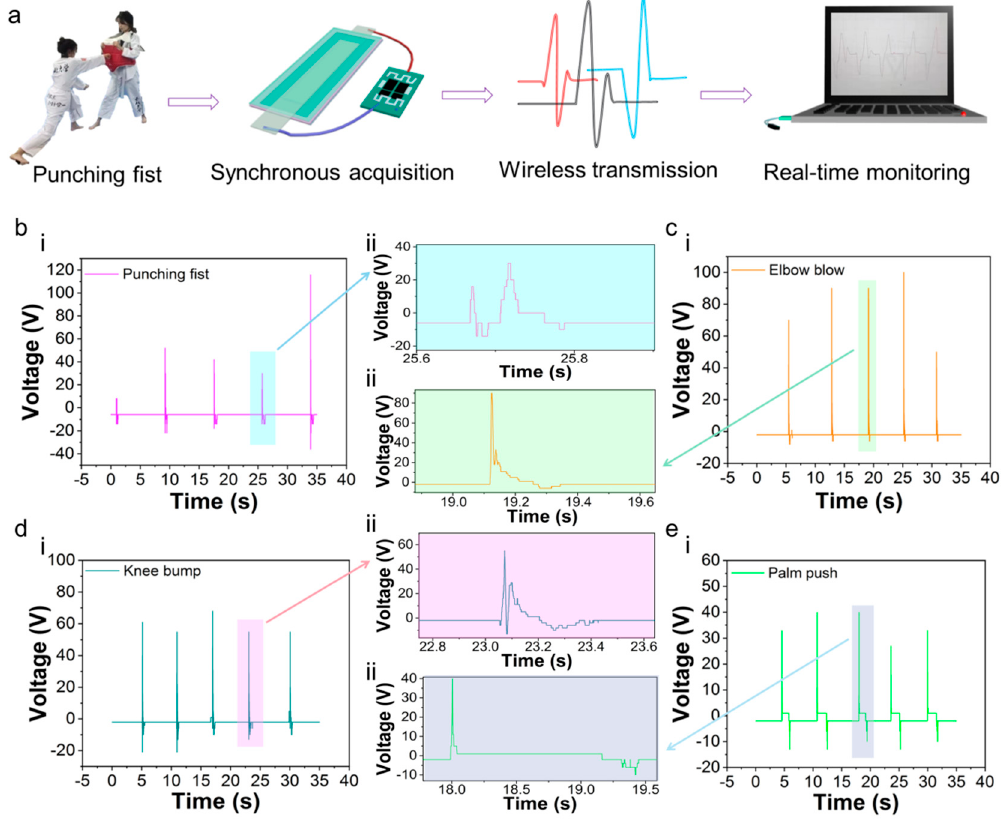
Figure 6. FL-TENG monitoring foul action and monitoring system. ( a ) Unsportsmanlike action monitoring system. ( b ) Voltage and waveform generated by punching. (i) The punching fist voltage graphs. (ii) The detail graphs of punching fist voltage. ( c ) Voltage and waveform generated by elbow blow. (i) The elbow blow voltage graphs. (ii) The detail graphs of elbow blow voltage. ( d ) Voltage and waveform generated by knee bump. (i) The knee bump voltage graphs. (ii) The detail graphs of knee bump voltage. ( e ) Voltage and waveform generated by palm push. (i) The palm push voltage graphs. (ii) The detail graphs of palm push voltage.